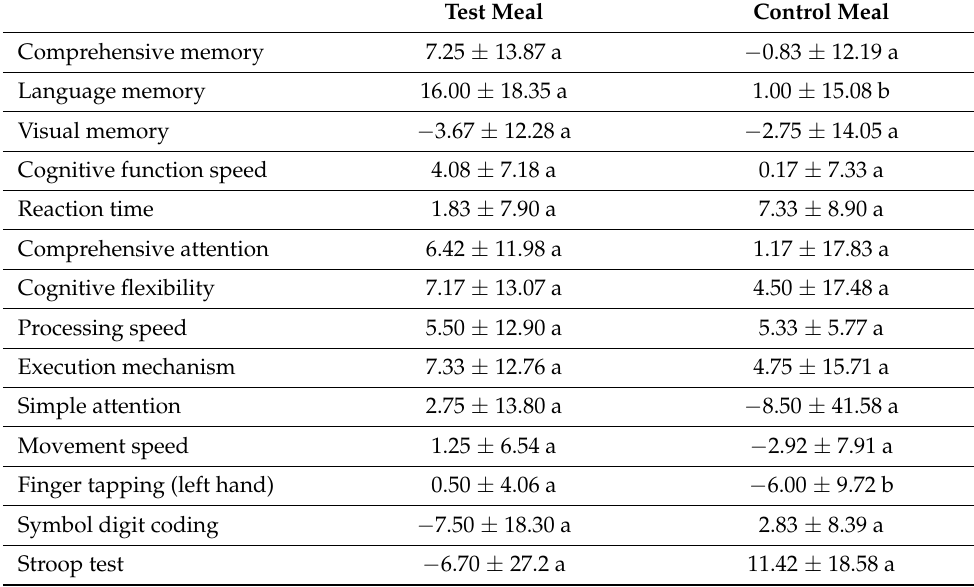
Table 8. Results of Cognitrax.